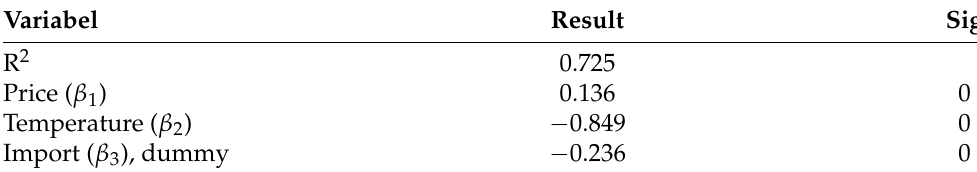
Table 9. Estimates of R 2 , β 1 , β 2 and β 3